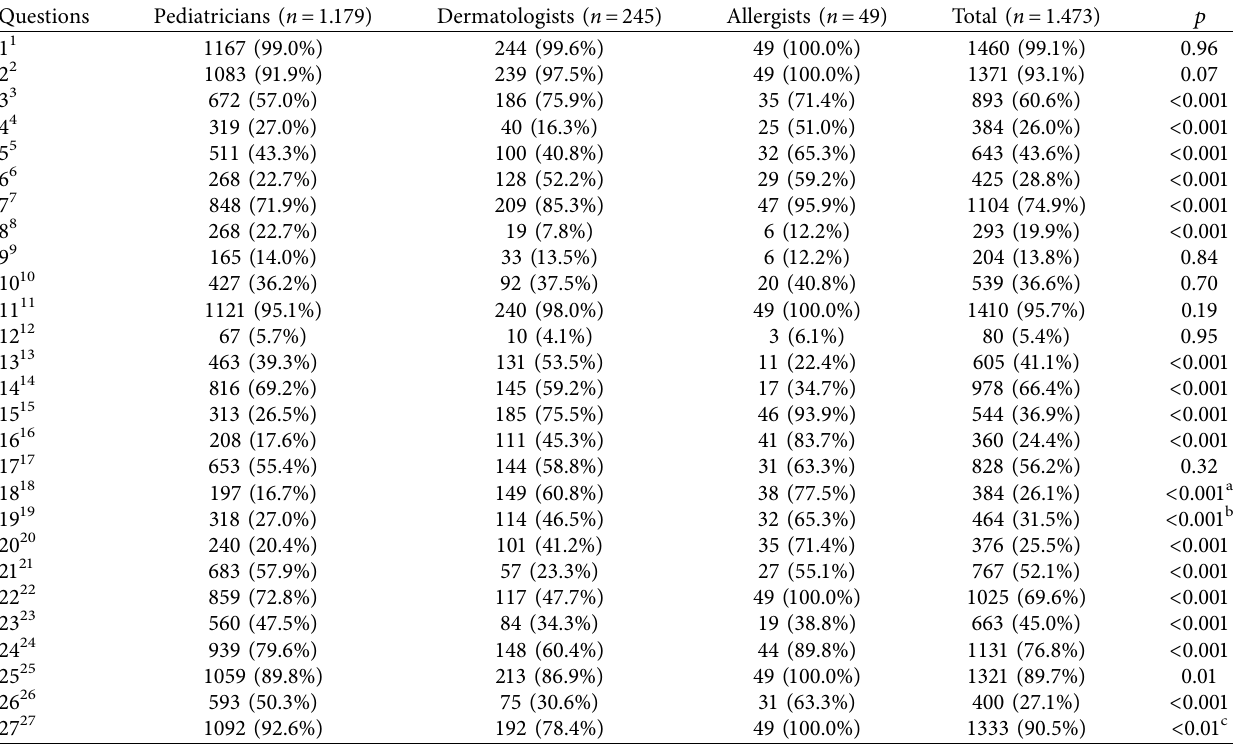
Table 2: Questionnaire answers (always and almost